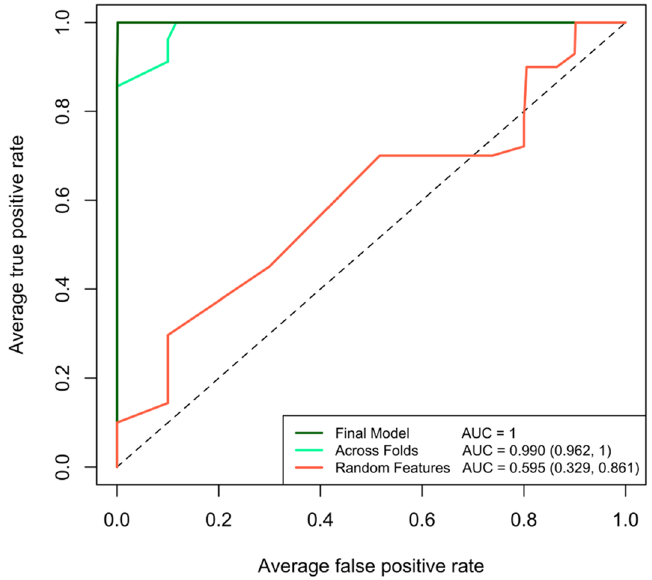
Figure 2. The receiver operating characteristic curves from the random forest model used to classify confirmed TB from unlikely TB patients. The final model demonstrates perfect classification but is almost certainly overfit to the data. The AUC observed across folds using the identified breathprint is 0.99, demonstrating very good sensitivity and specificity across all folds of the data. In comparison, a randomly selected 4-compound breathprint only demonstrated an AUC of 0.595 across cross validation folds of the data. Figure created in R 73 .